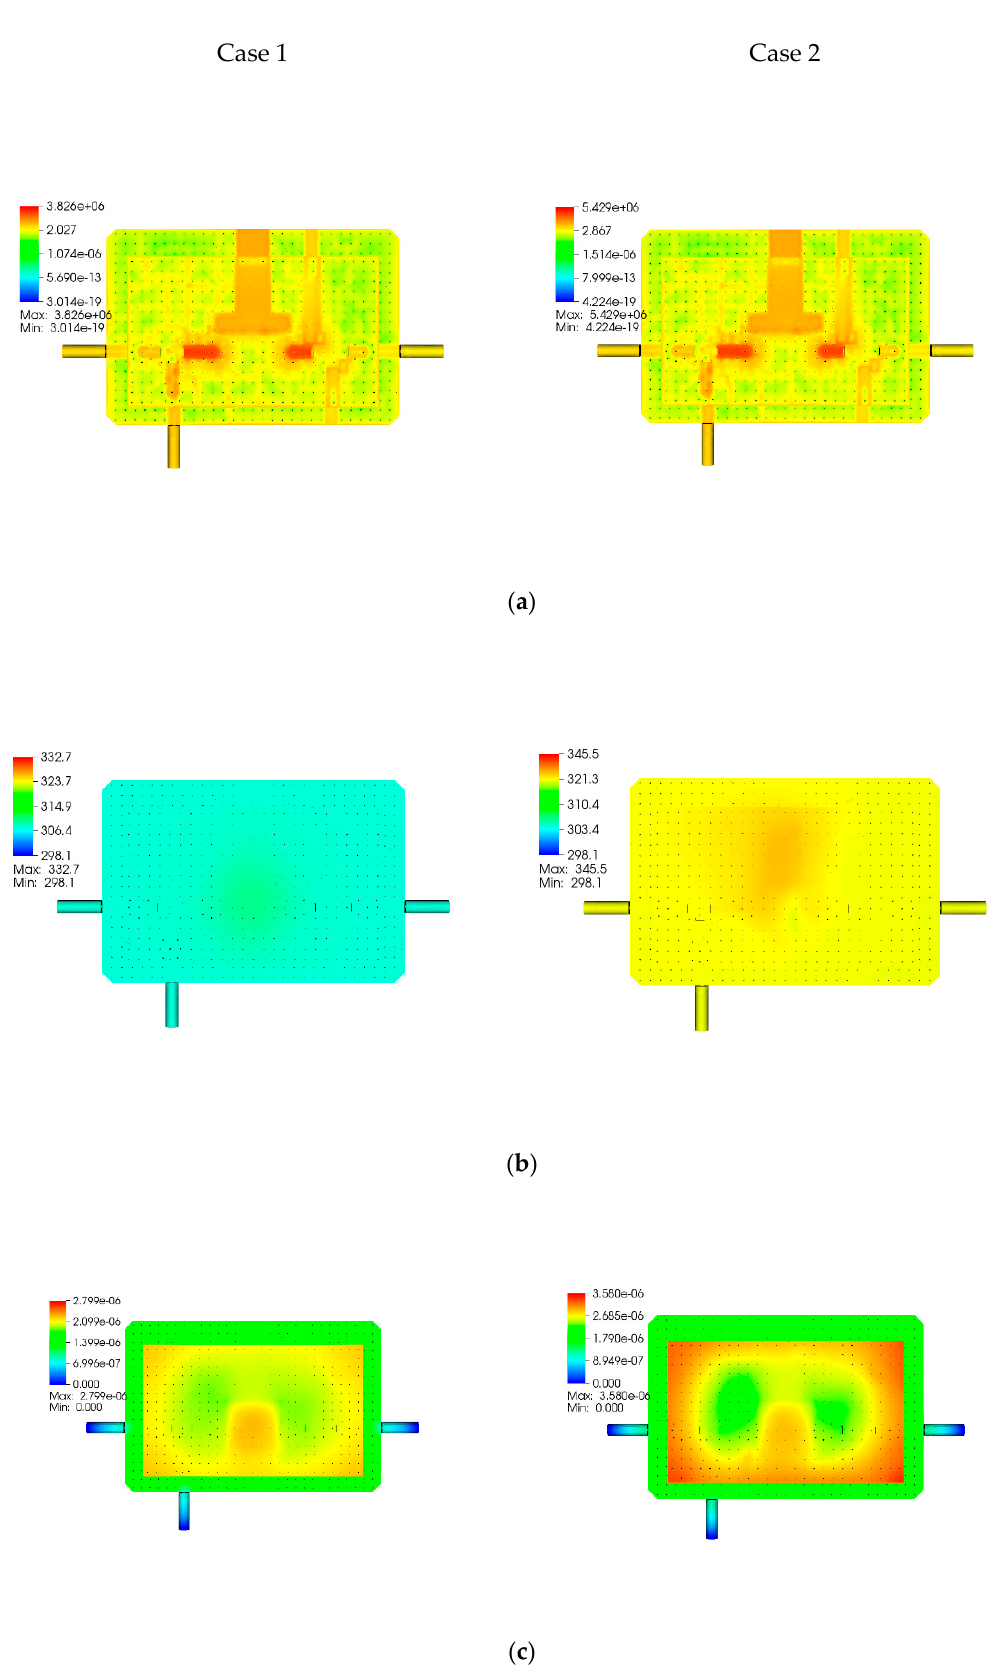
Figure 8. Calculated results of the real-life transceiver for two cases: ( a ) electric field with dimensions of V/m, ( b ) temperature field with dimensions of K, and ( c ) strain field with dimensions of m.